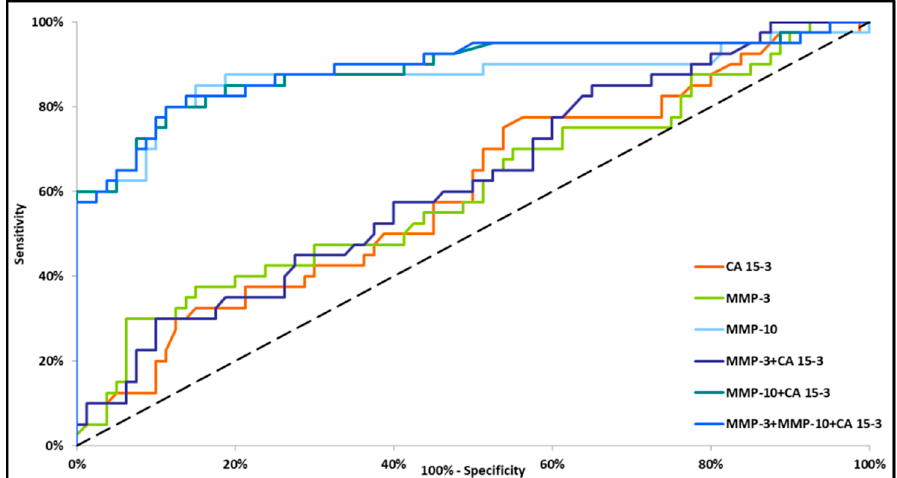
Figure 2. Diagnostic criteria of the ROC curve in stage I of BC. CA 15-3—cancer antigen 15-3; MMP-3—stromelysin-1;